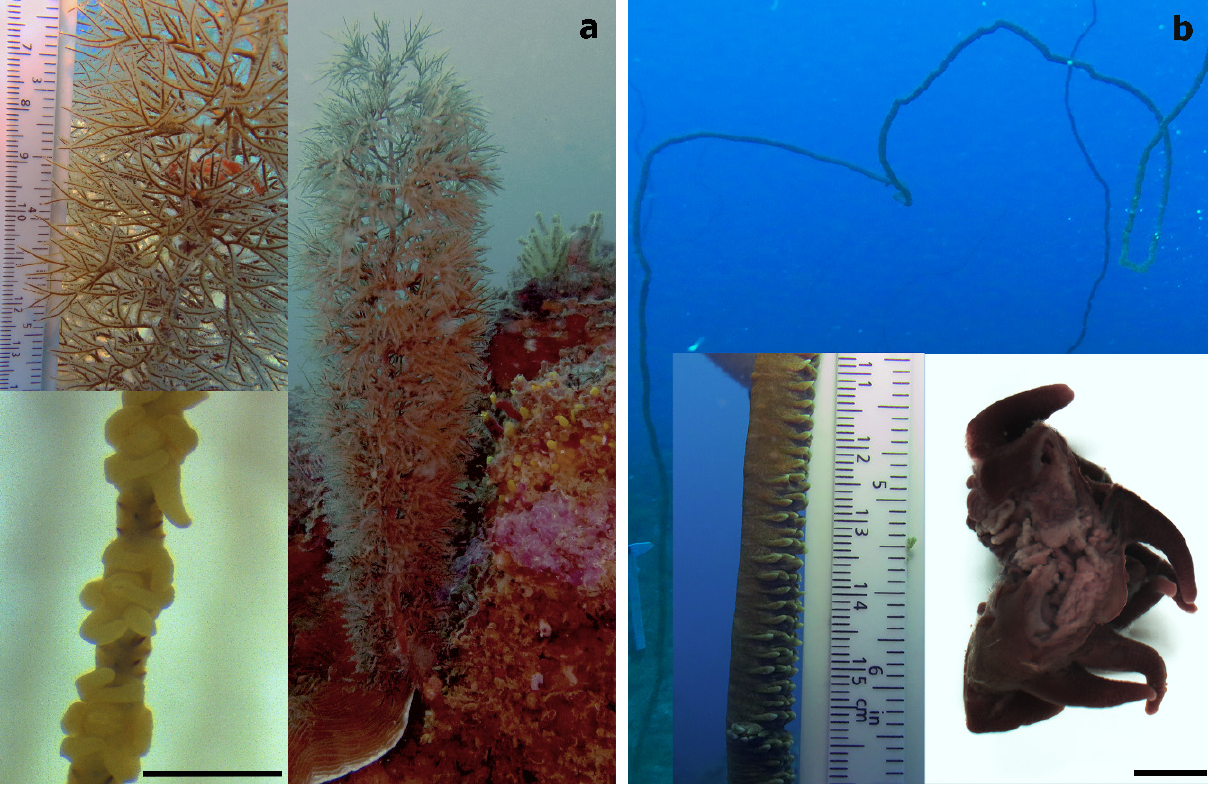
Figure 2. ( a ) The bottle-brush-like Cupressopathes abies and ( b ) the whip-like Stichopathes maldivensis , with an image showing a section of two individual polyps in the bottom right corner. Scale bars of polyp images = 1 mm.